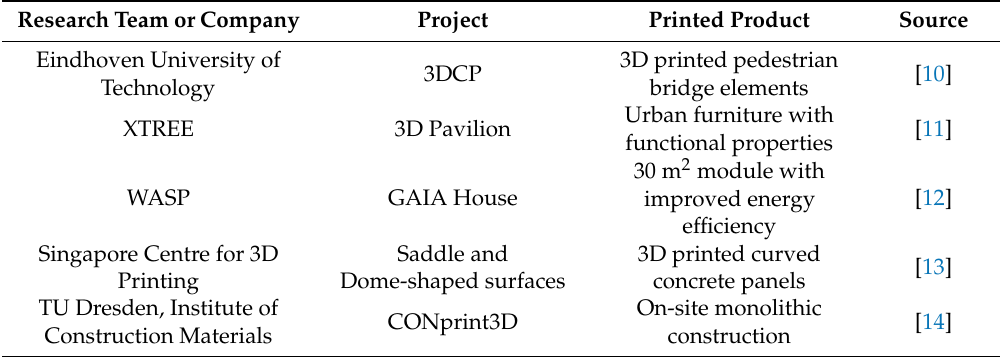
Table 1. An overview of the main industrial and academic research projects operating in cement materials extrusion-based additive manufacturing